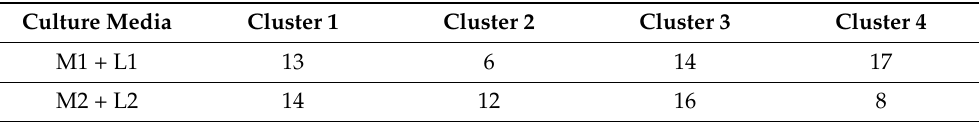
Table 2. Number of hybrid strains of Pleurotus djamor cultivated on different culture media belonging to each cluster using the clustering K-medoids